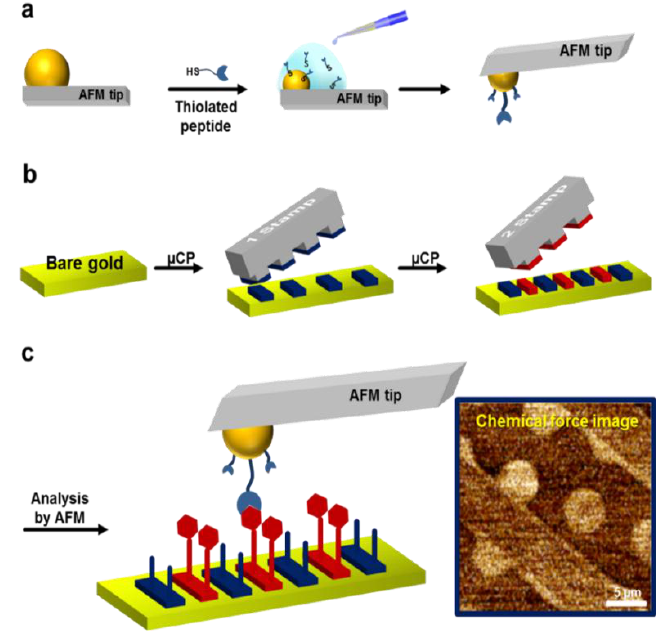
Scheme 1 . The schematic presentation of the strategy for fabricating a mixed organic pattern